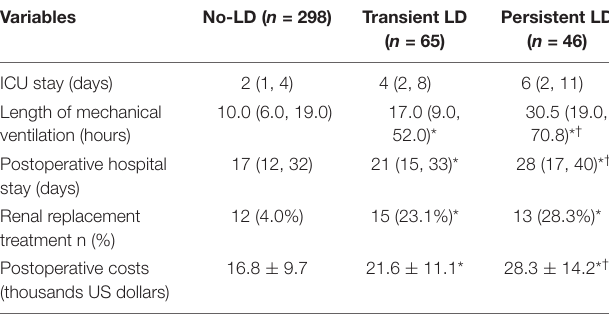
TABLE 4 | Postoperative short-term outcomes of the study